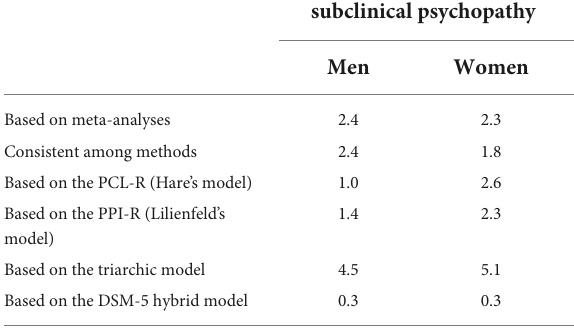
TABLE 3 Prevalence (%) of clinical psychopathy and subclinical psychopathy in the sample of participants as a function of the different definitions of the psychopathy construct and according to sex ( N = 292 men and 390